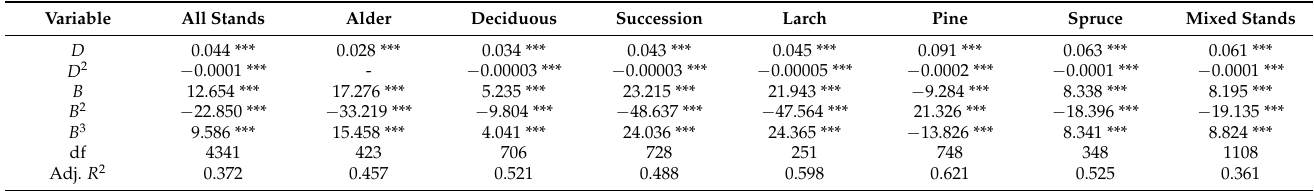
Table 1. Estimated regression parameters of the diameter growth model (Equation (9)).